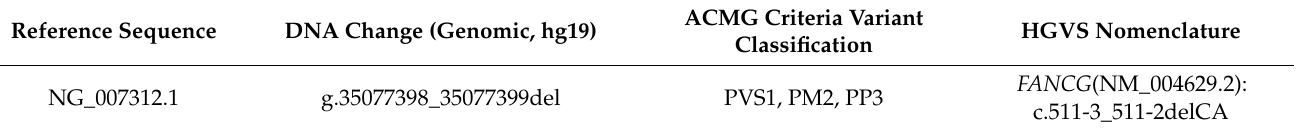
Figure 1. DEB-induced chromosomal aberrations in lymphocytes from healthy and FA individuals. DEB: diepoxybutane. ( A ) Representative metaphase from a healthy individual (negative control); chromosome aberrations are mainly chromatid breaks. ( B ) Representative metaphase from one of the FA patients; increased chromosome aberrations are observed showing chromatid breaks and radial figures, characteristics of patients with FA. Blue arrows show chromatid and isochromatid breaks and red arrows show radial figures. ( C ) Frequency of chromosomal aberrations per cell for each FA patient analyzed in this study. Table 1. Features of the pathogenic variant found in FANCG